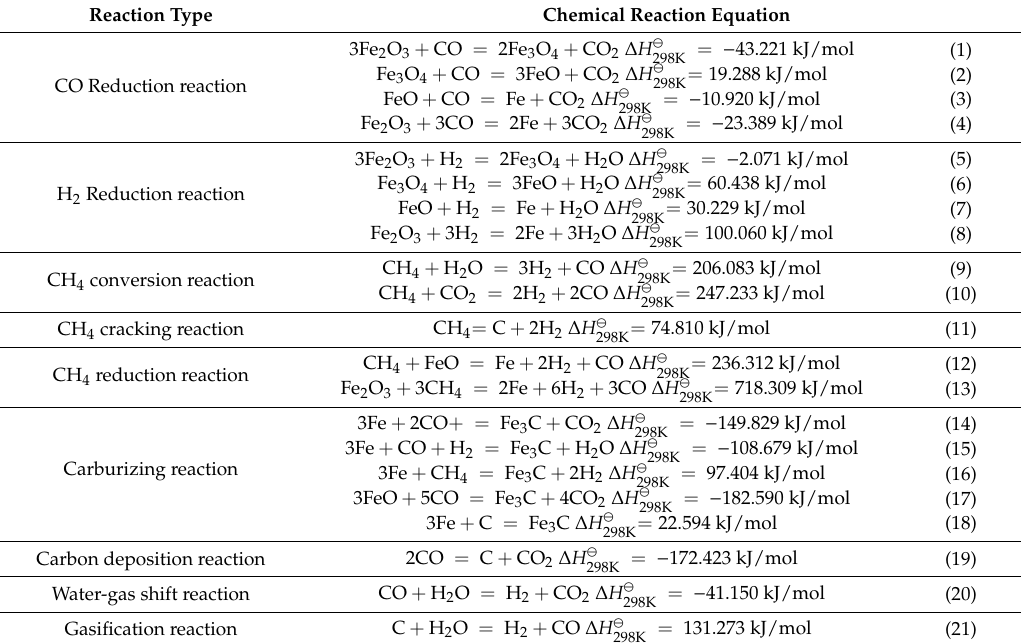
Table 2. The main reactions between Fe 2 O 3 and H 2 + CO + CH 4